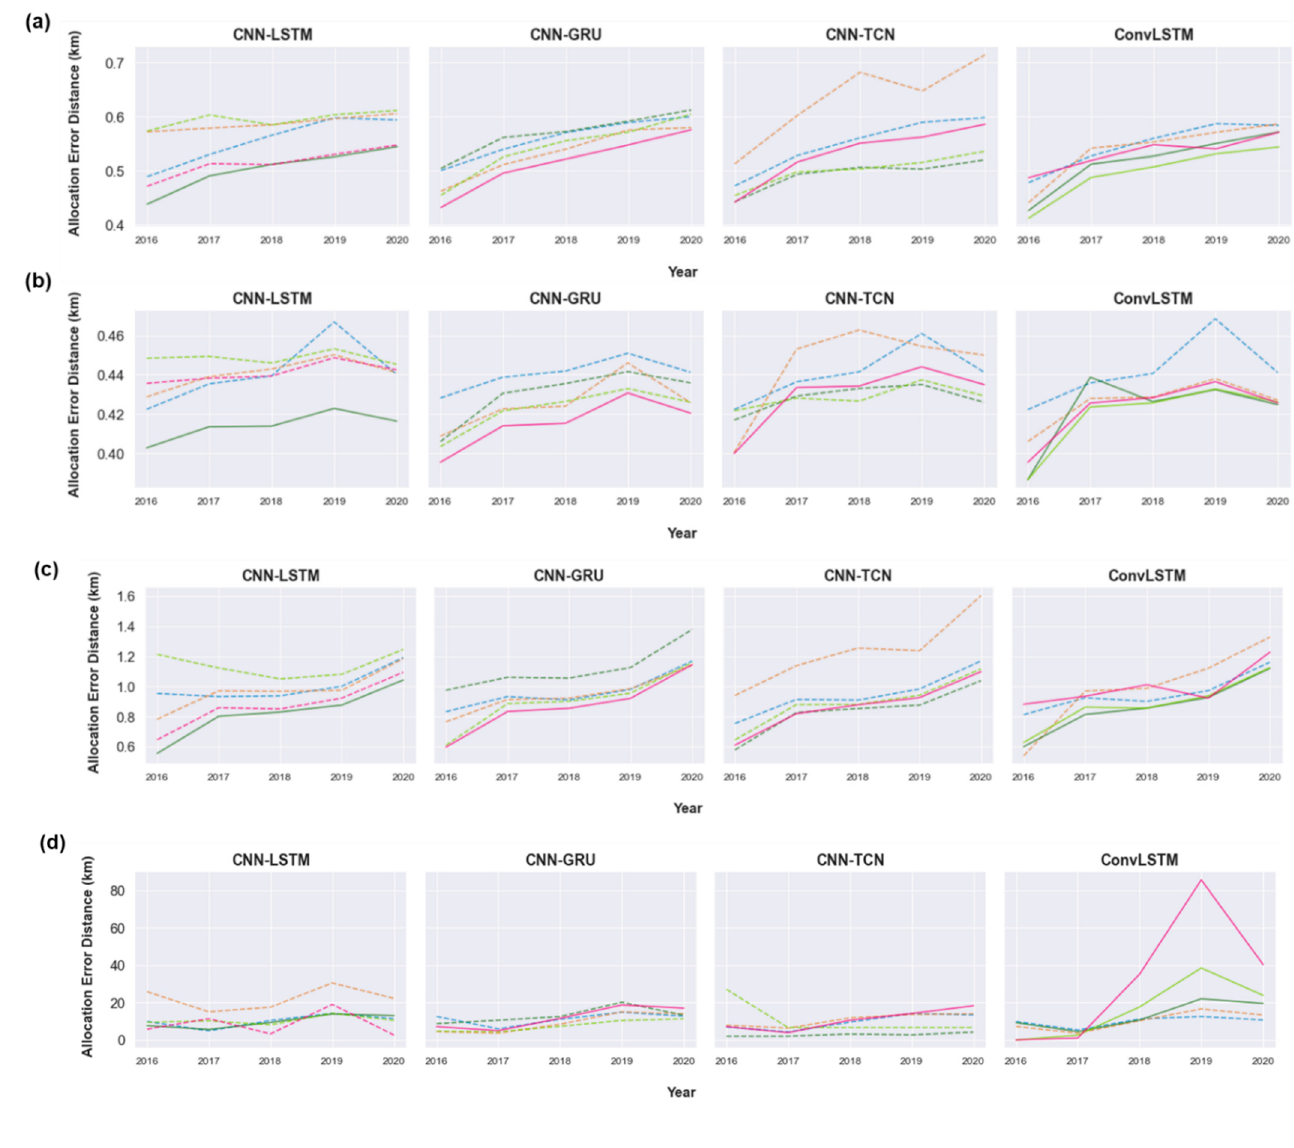
Figure 8. Average allocation error distance from real-world allocations in 2016–2020 considering ( a ) AED overall , ( b ) AED large , ( c ) AED medium , and ( d ) AED small . The model and sample weight combinations with the top six FOM values are indicated by bold lines.